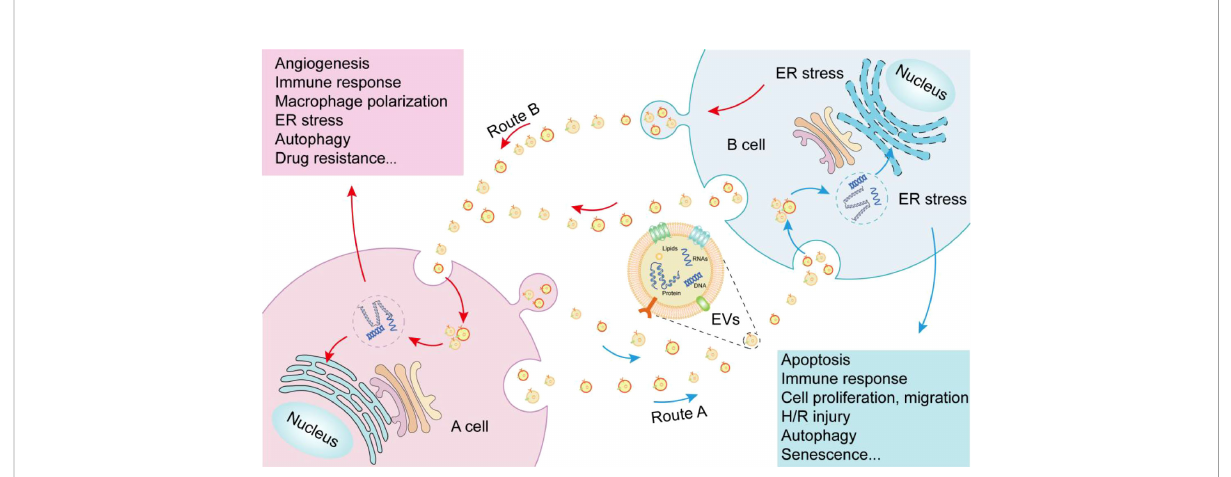
FIGURE 2 Interactions between endoplasmic reticulum stress (ER) and extracellular vesicles (EVs). Route A: EVs released by A cell are internalized by B cell, and the contents of EVs cause ER stress in B cell, ultimately causing a number of outcomes in B cell. Route B: EVs released by B cell under ER stress are internalized by A cell, which can transmit endoplasmic reticulum stress to A cell and cause a series of outcomes in A